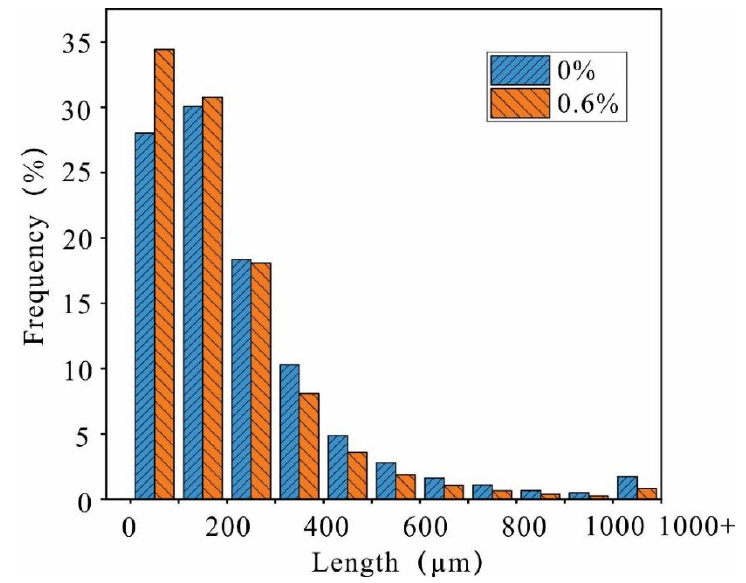
Figure 20. Frequency distribution of the pore length.